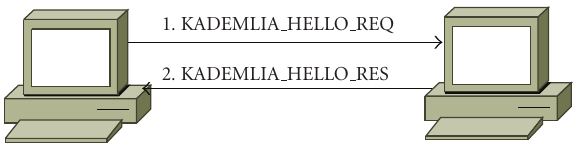
Figure 6: Correct heart-beat checking between two normal eMule